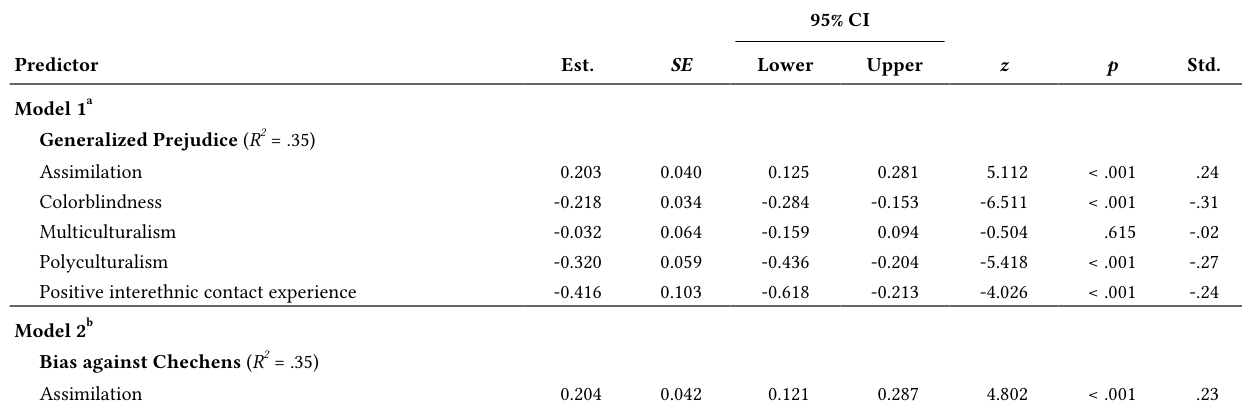
Model Results for Structural Equation Model: Unstandardized Coefficient (Est.), Standard Error (SE), 95% Confidence Interval (CI), Standardized Coefficient (Std.), z-Value (z) and Significance in Study 1 (N = 359) Predictor